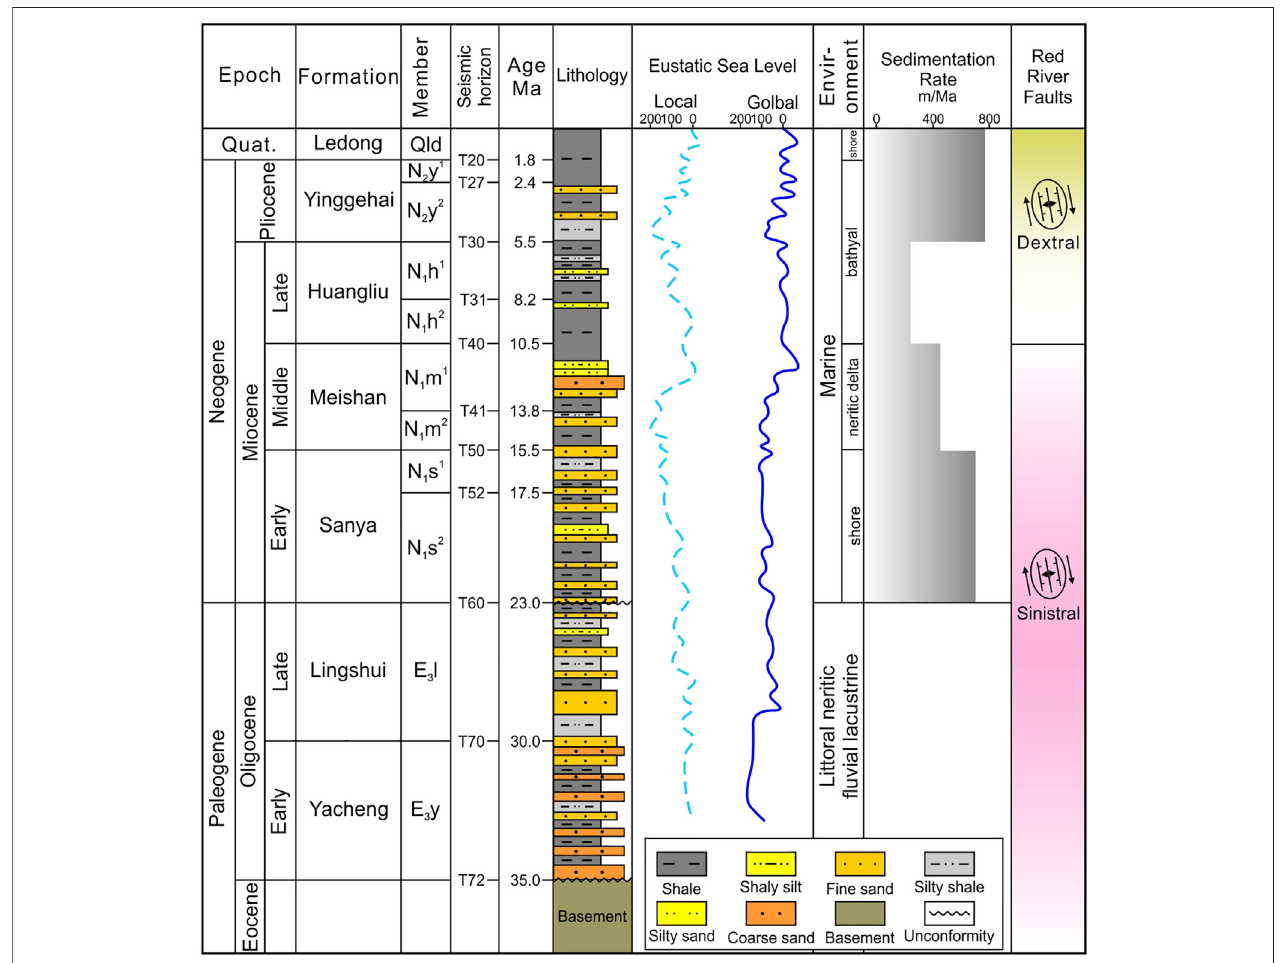
FIGURE 2 | Comprehensive stratigraphic pro fi le of the Yinggehai Basin, showing the formation and symbols, seismic horizons, and main lithology (Modi fi ed from Fan et al., 2021).